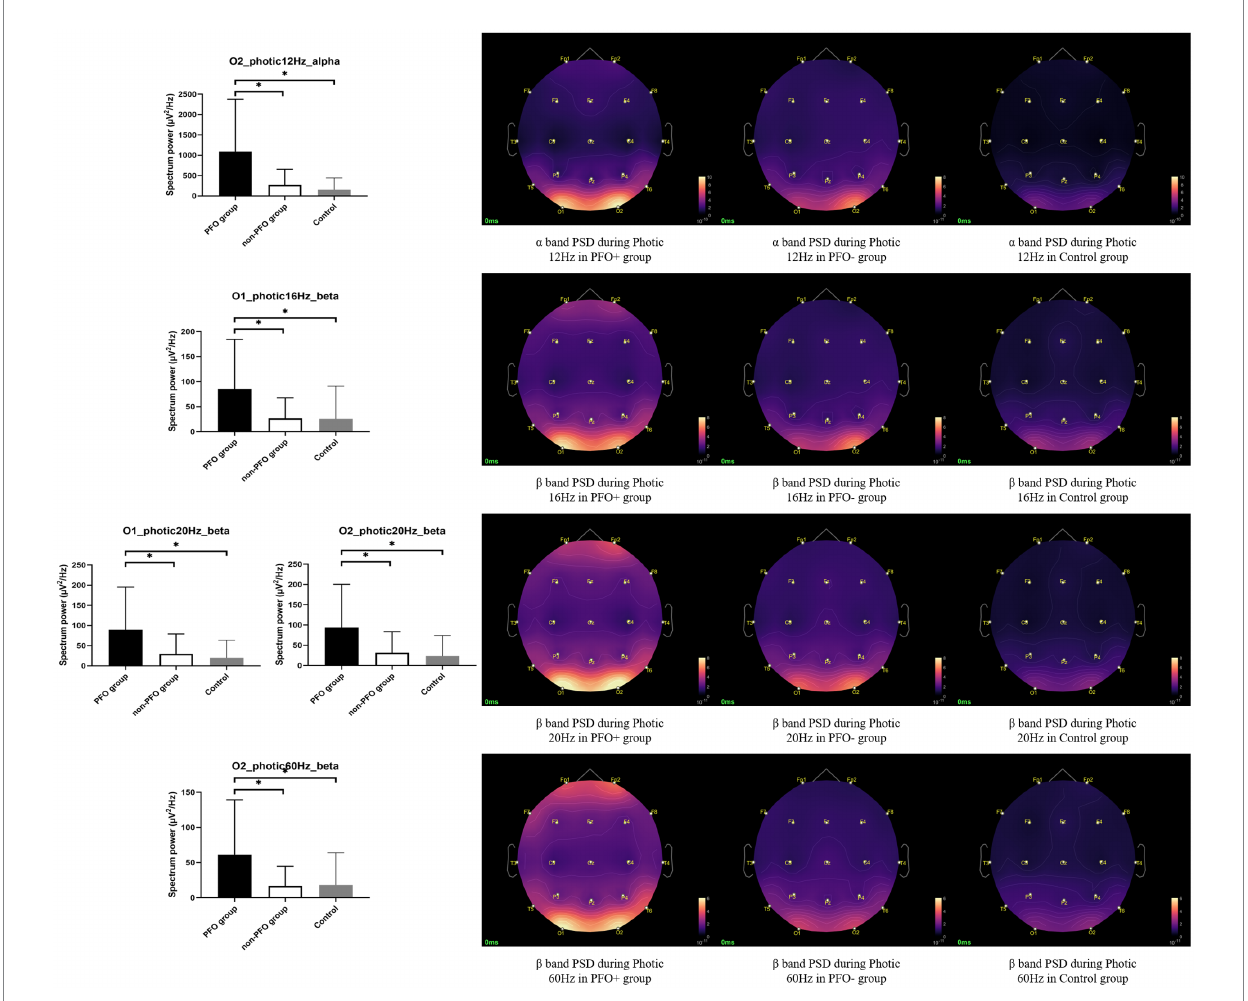
FIGURE 1 Comparison of alpha and beta band power spectrum density (PSD) on the occipital region during photic stimulation among patent foramen ovale (PFO) + group ( n = 35), PFO-group ( n = 35) and Control group ( n = 20). The alpha band PSD on the occipital region was significantly increased in the PFO + group during photic stimulation at 12 Hz, and beta band PSD on the occipital region was significantly increased during photic stimulation at 16, 20, and 60 Hz, as shown by box graphs. The PSD topography on the right side provides a more intuitive representation of the distinction between the two groups. * adjusted p <